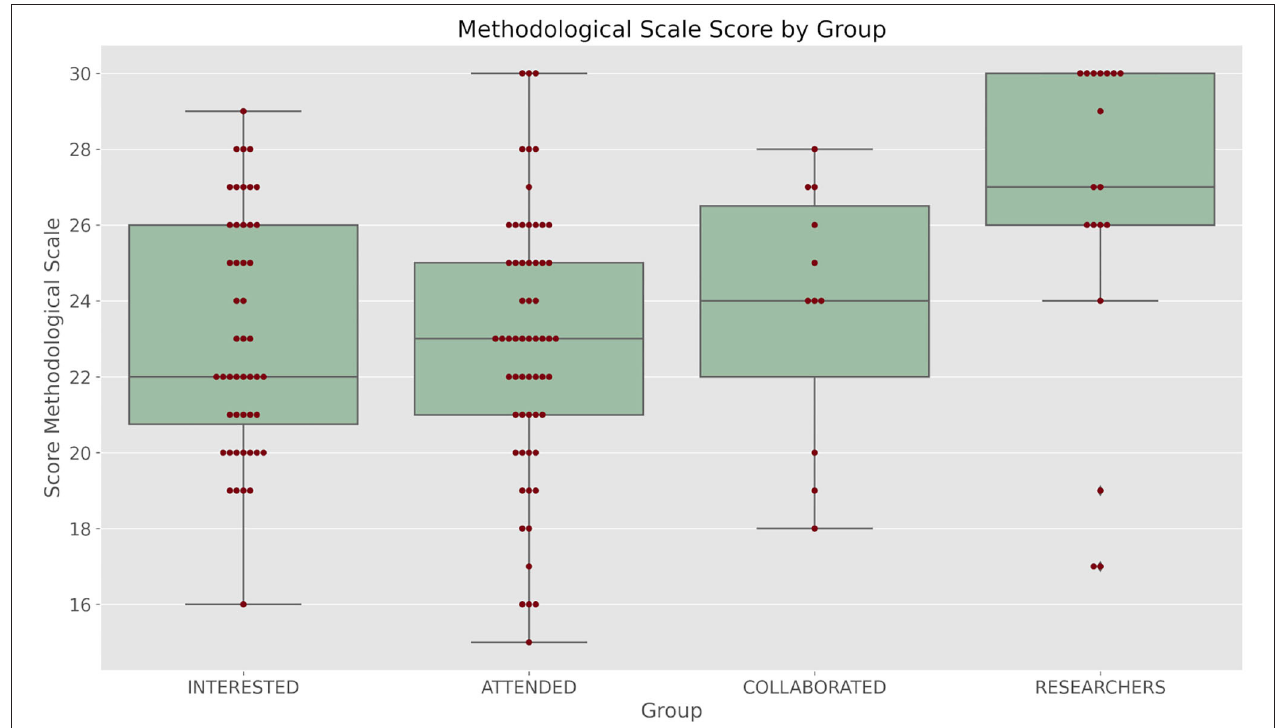
FIGURE 3 | Boxplots of the scores obtained in the methodological/epistemological questionnaire by each